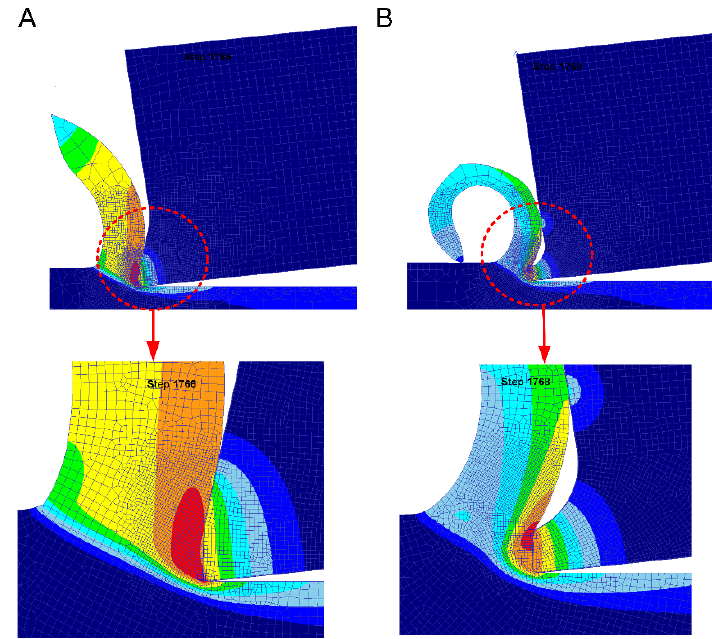
Figure 19. ( A ) Tool–chip contact diagram of Tool A. ( B ) Tool–chip contact diagram of Tool B.